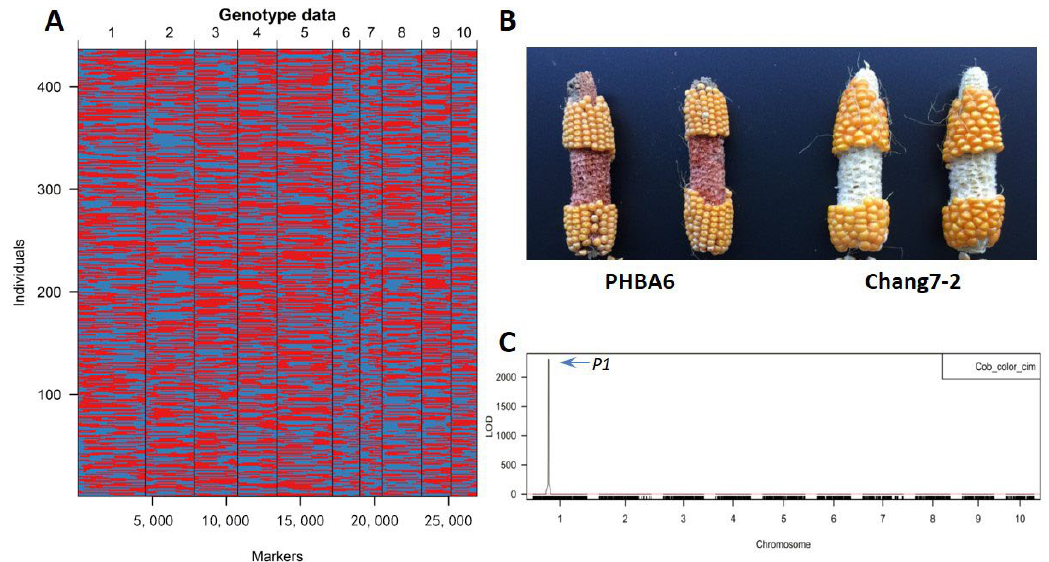
Figure 3. A genetic map of the DH population and QTL mapping of the cob color gene Pericarp1 ( P1 ). ( A ) Graphical representation of the genotypes of 571 DHs. Red, PHBA6 genotype; blue, Chang7-2 genotype. ( B ) Image showing the cob colors of PHBA6 (red) and Chang7-2 (white). ( C ) Results of QTL mapping of cob color in the DH population. The QTL peak corresponding to the P1 gene is indicated. The dotted red line corresponds to the cutoff line.